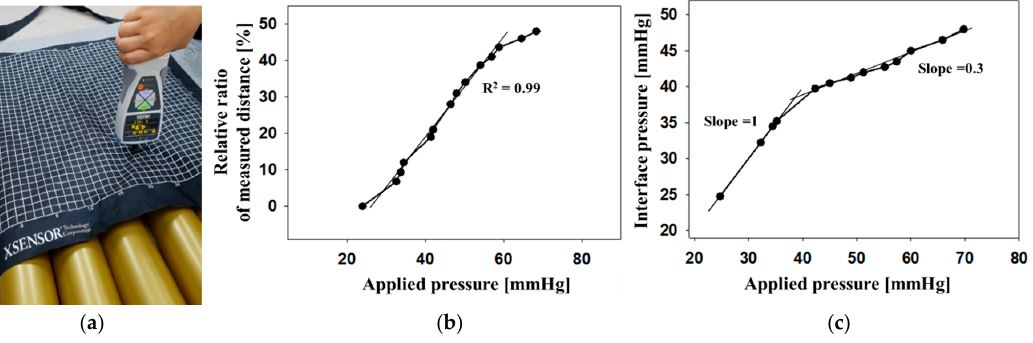
Figure 8. ( a ) Picture for measurement method, ( b ) the relative ratio in the measured distance and ( c ) the interface pressure at pressures applied by manual forces.